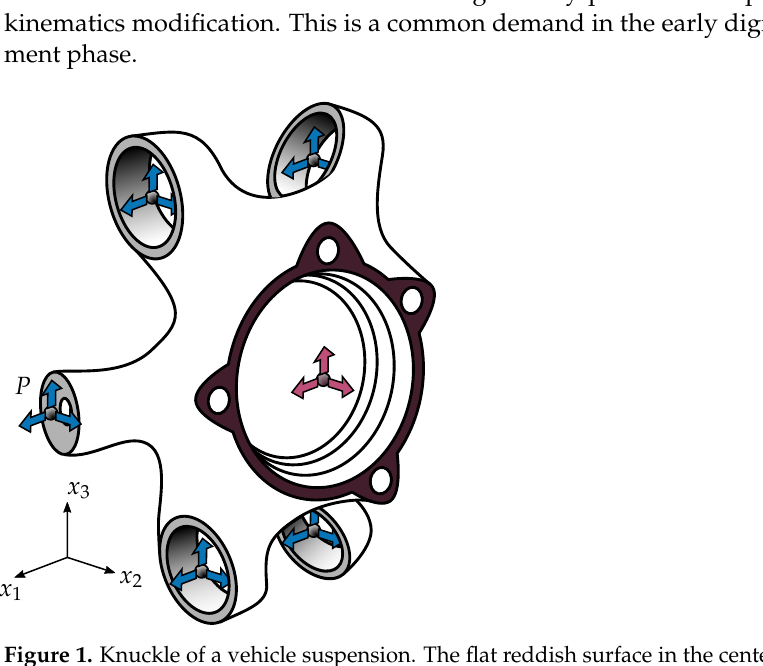
Figure 1. Knuckle of a vehicle suspension. The flat reddish surface in the center represents the wheel hub attachment surface. Gray spheres inside gray surfaces represent variable kinematic hard points. FRFs describe the noise transfer between each blue arrow and each red arrow. Each arrow represents one of the three directions x 1 , x 2 or x 3